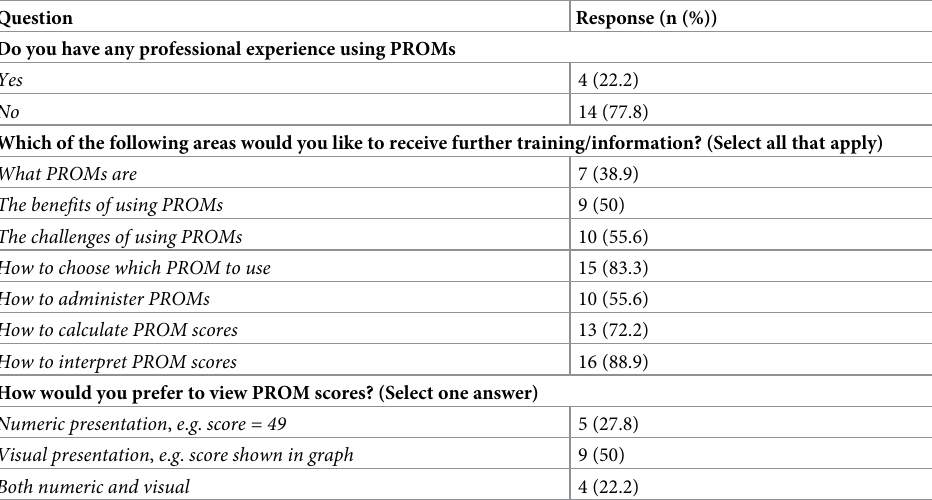
Table 1. Clinicians’ self-reported experience, training needs, and preferences for viewing PROM data.